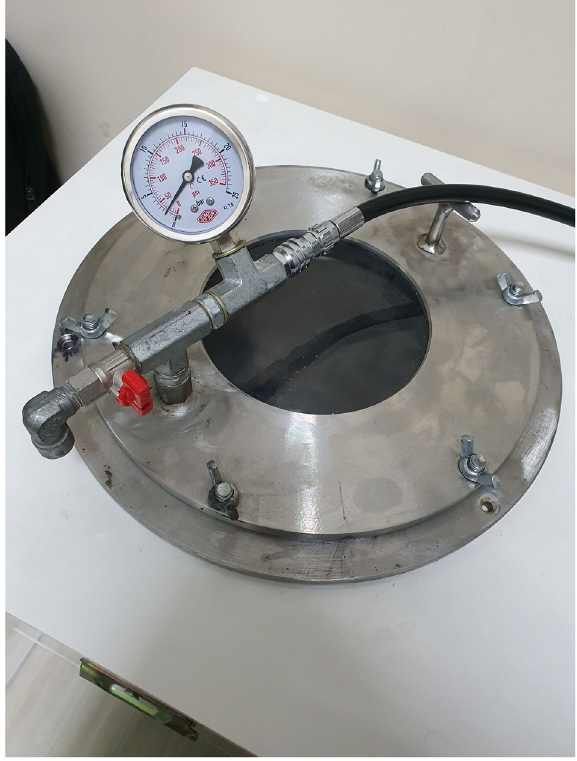
Fig. 3 10-l steel pressure vessel for HBOT pressure